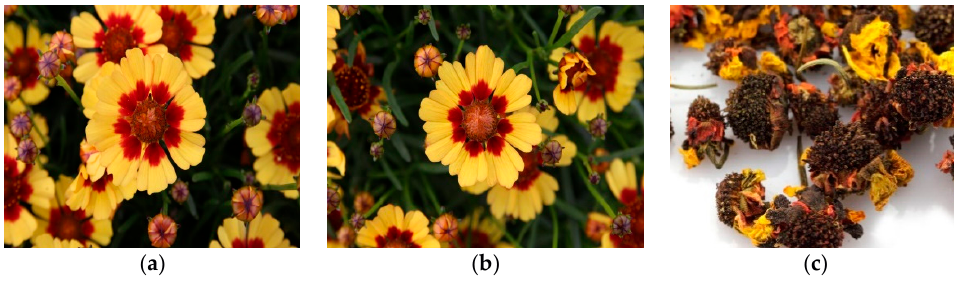
Figure 1. The flowers of ( a ) the gamma-irradiated mutant cultivar, “golden ring”; ( b ) its original cultivar, “pumpkin pie”; ( c ) the commercially available tea material, “snow chrysanthemum” (photographed by authors, Y.G.J. and B.-R.K.) .